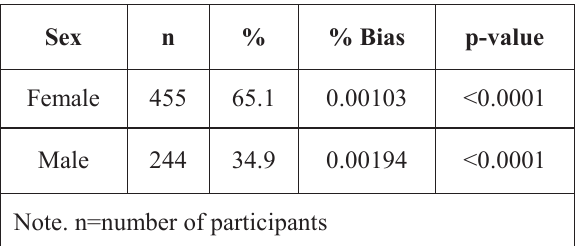
Table-1: Analysis of groups by gender